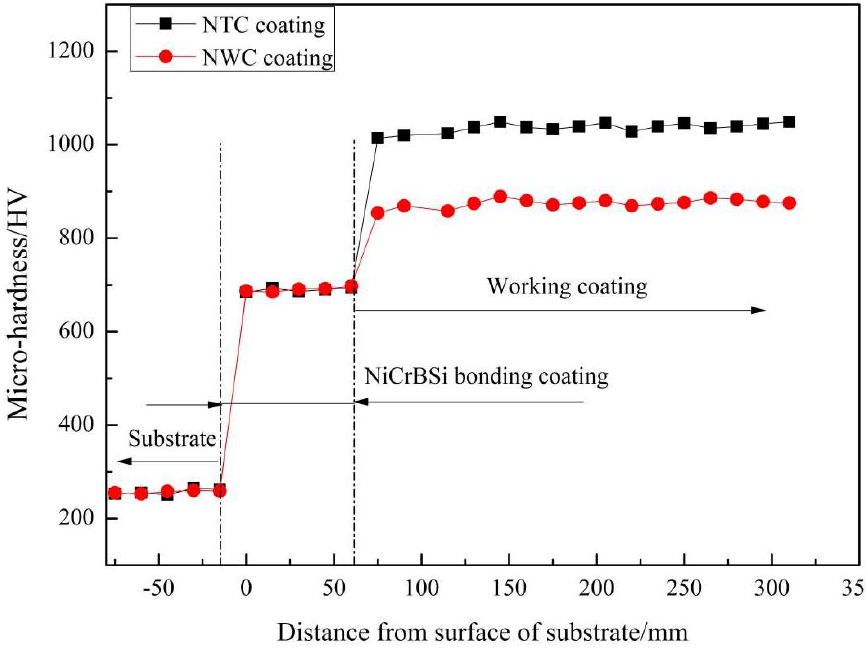
Figure 7. Microhardness of NTC and NWC coatings.